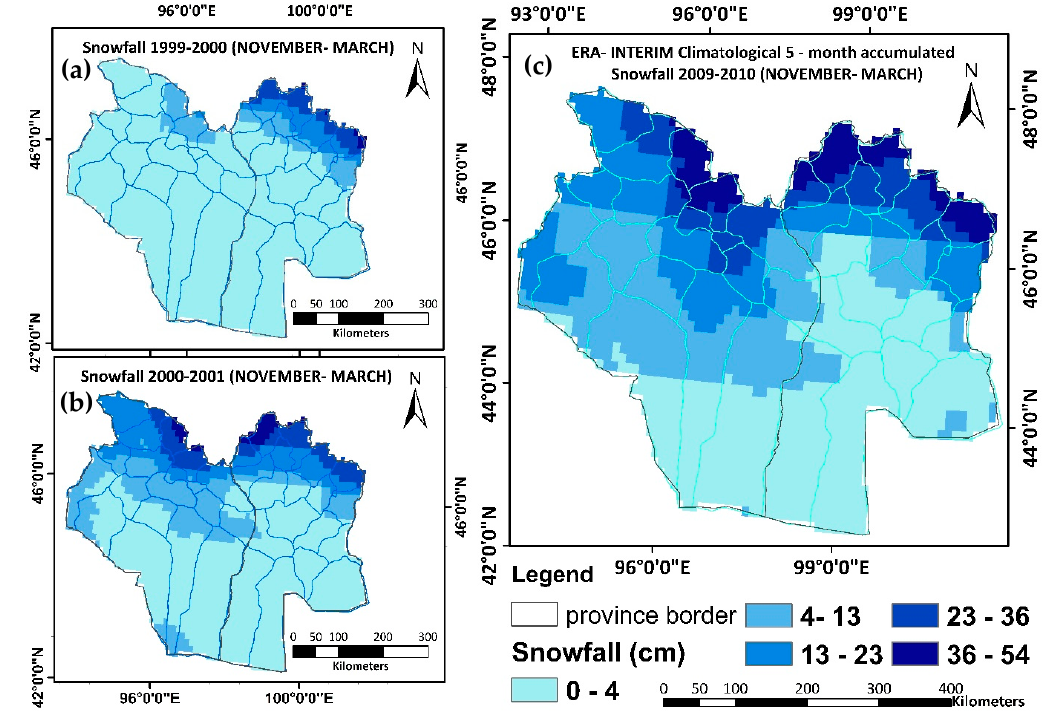
Figure 8. The spatial distribution of snowfall maps (between November and March), from ( a ) 1999/2000; ( b ) 2000/2001 and ( c ) 2009/2010.